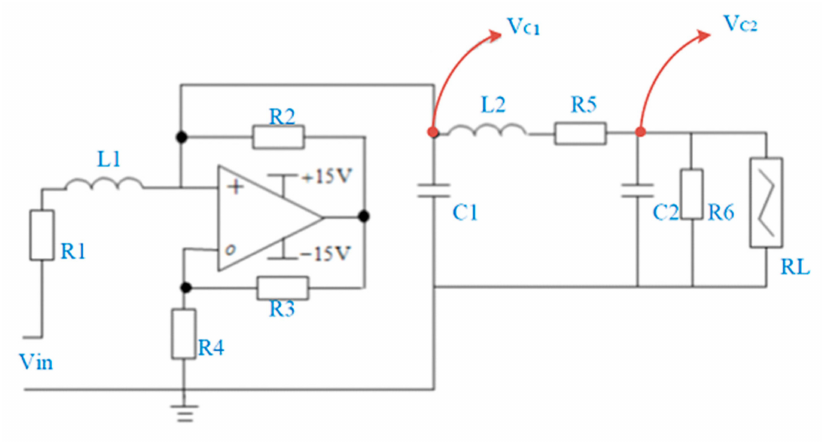
Figure 1. Chua’s